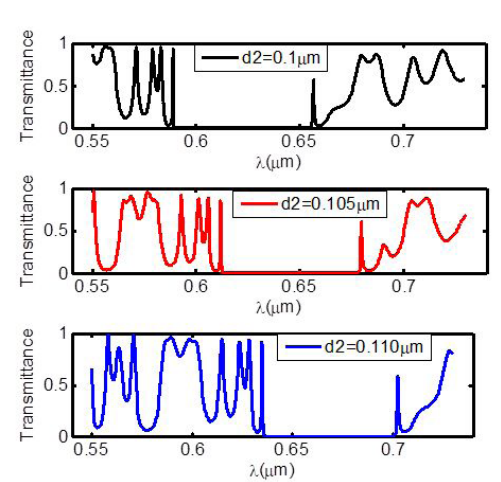
Figure 5. Transmittance spectra simulated on the quasi-periodic 1D PC structure with d2 varied to be 0.1, 0.105, and 0.110 µm while d3 is fixed to be at 0.08µm.